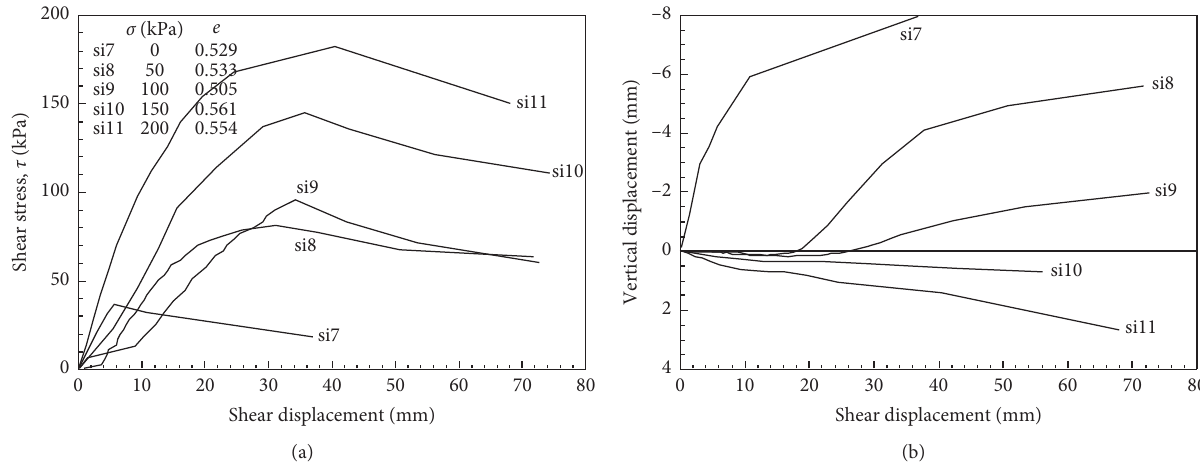
Figure 6: Data of the in situ direct shear tests under humid condition. (a) Shear stress versus shear displacement. (b) Vertical displacement versus shear displacement.